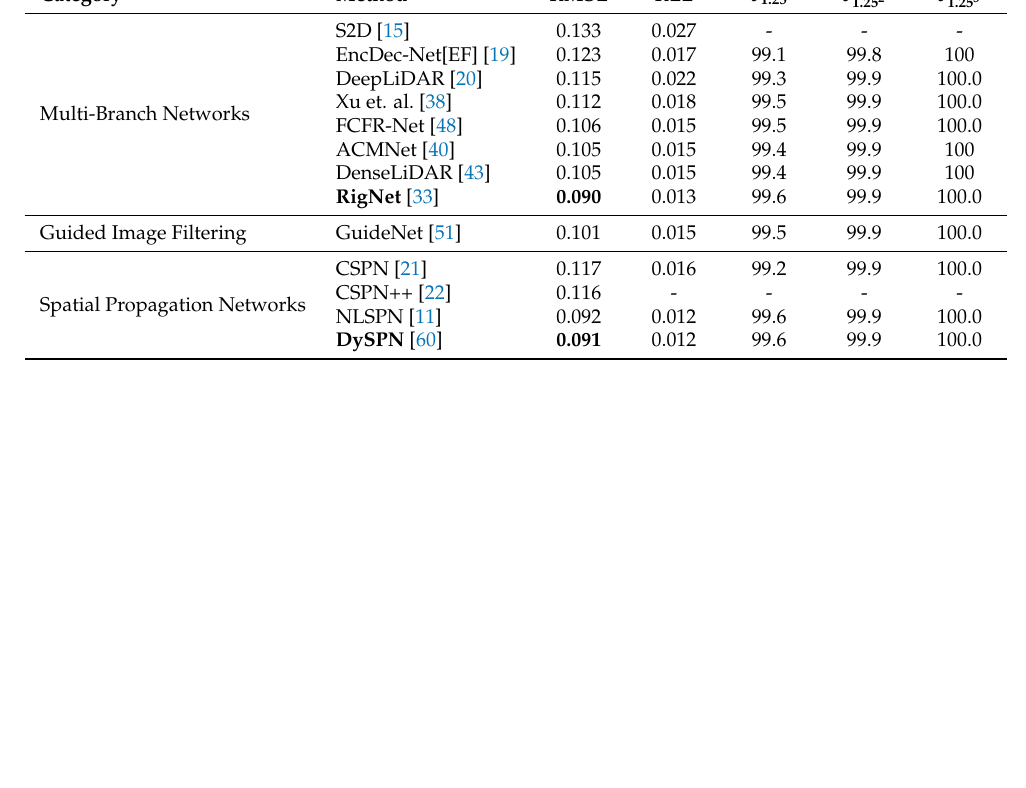
Table 3. Comparison of state-of-the-art approaches on the NYUv2 Benchmark dataset. Performances are reported for 500 samples. The methods are ordered by their RMSE results from worst to best within each category. The best results within each category are mentioned in bold letters. δ i denotes the percentage of predicted pixels whose relative error is less than a threshold i (1.25, 1.25 2 , and 1.25 3 ).